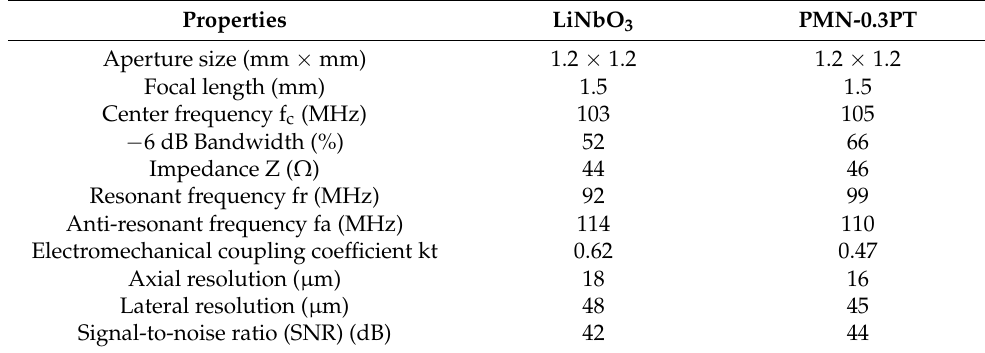
Table 4. Measured transducer characteristics.